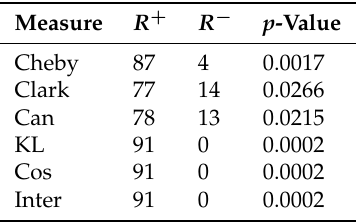
Table 5. Wilcoxon Signed Ranks test comparing ProLSFEO-LDL vs. AA- k